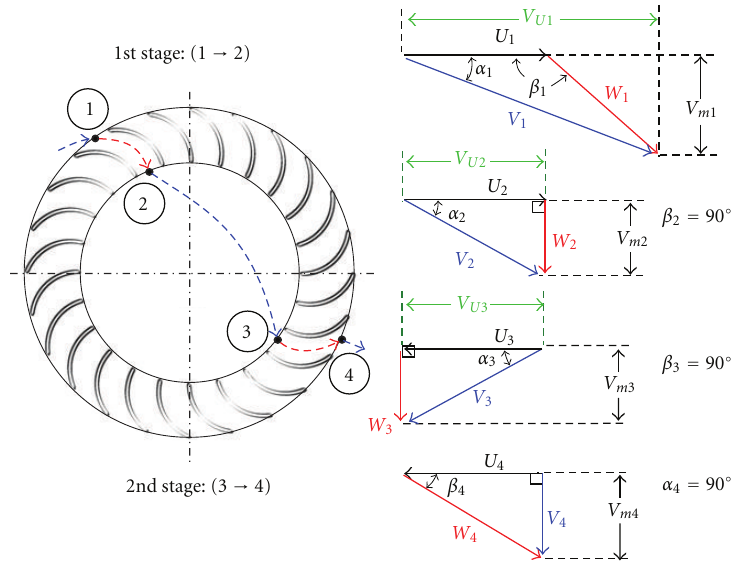
Figure 3: Theoretical velocity triangles of a cross-flow turbine